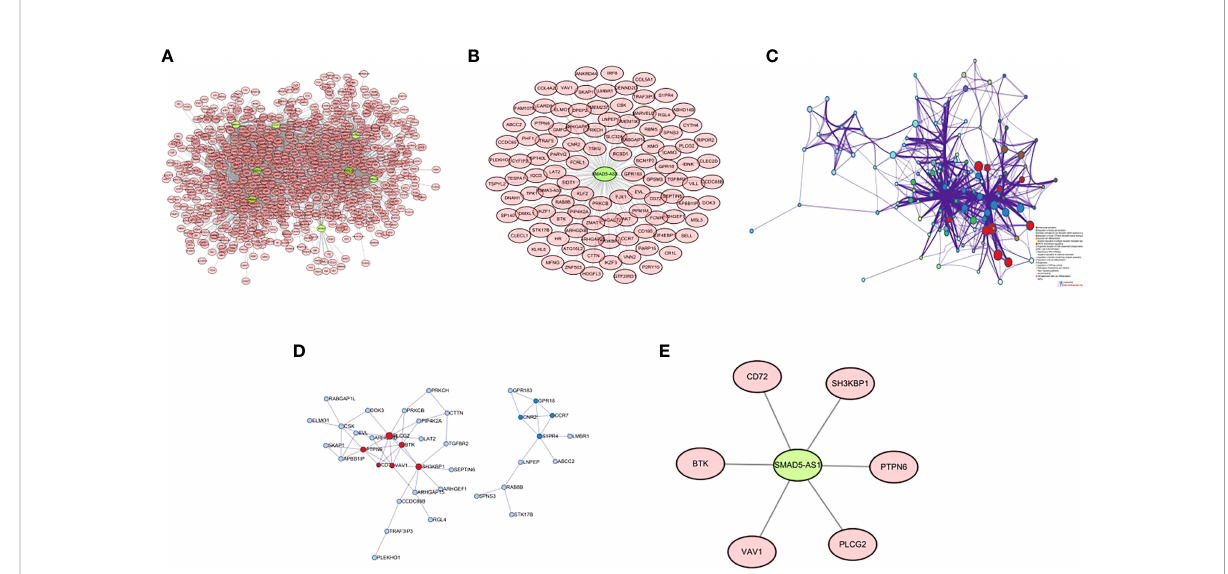
FIGURE 3 Construction of lncRNA-mRNA co-expression network and PPI network. (A) lncRNA-mRNA co-expression network of 8 lncRNAs in SUR1 and SUR2 modules; (B) key lncRNA SMAD5-AS1 and mRNA co-expression network; (C) PPI network of co-expressed mRNAs in the co-expression network; (D) MCODE plug-in screening the highest-scoring sub-network; (E) SMAD5-AS1 and hub mRNA co-expression networks.